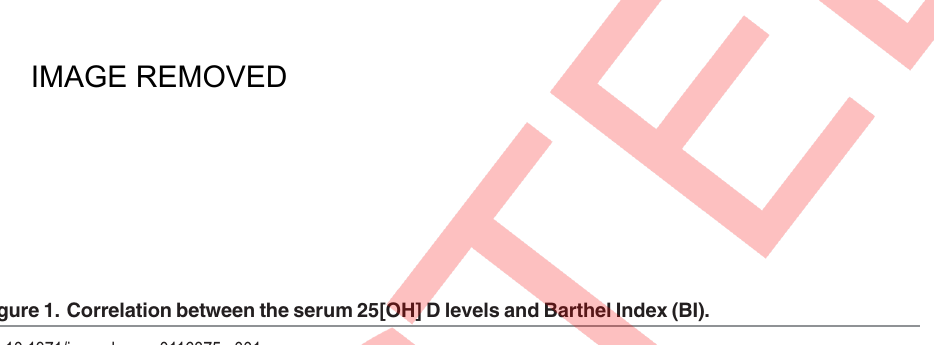
Figure 1. Correlation between the serum 25[OH] D levels and Barthel Index (BI).